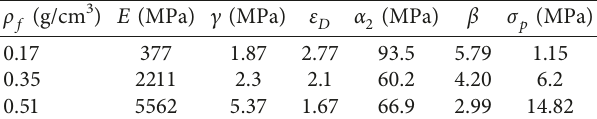
Figure 4: FE model.